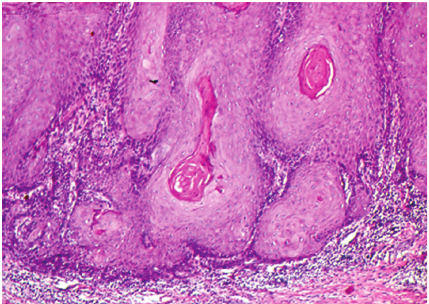
Figure 1: Verrucous white lesion in the right maxillary alveolar ridge, extending to buccal vestibule and cheek.